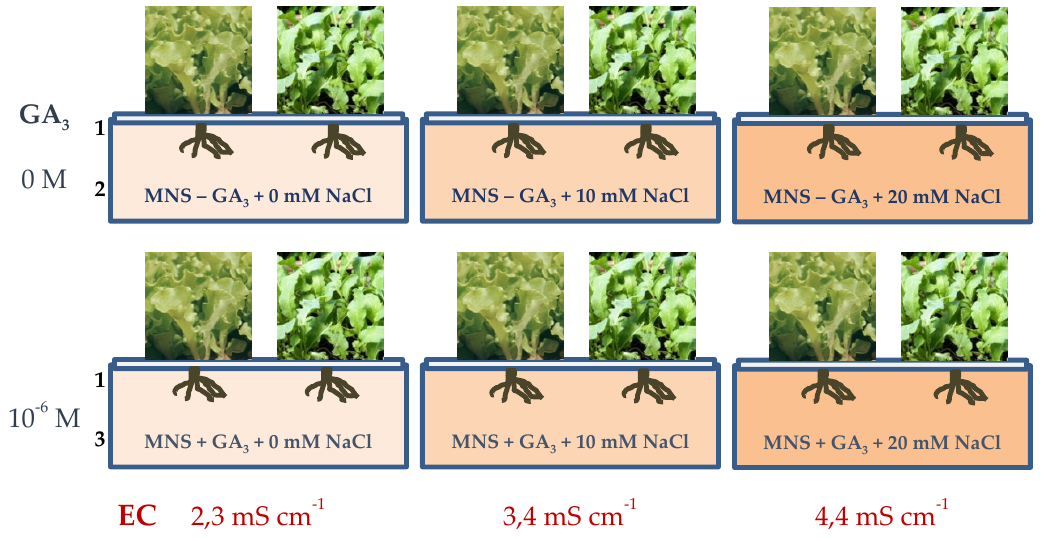
Figure 1. Graphical representation of the hydroponic floating system consisting of drilled polystyrene panels floating on mineral nutrient solutions with different combinations of gibberellic acid (GA 3 ) and NaCl levels. 1 Drilled polystyrene panels (300 plants m − 2 ) floating on mineral nutrient solution (MNS); Tanks containing 75 L of MNS added with increasing concentrations of NaCl and 2 0 M GA 3 or 3 10 − 6 M GA 3 .